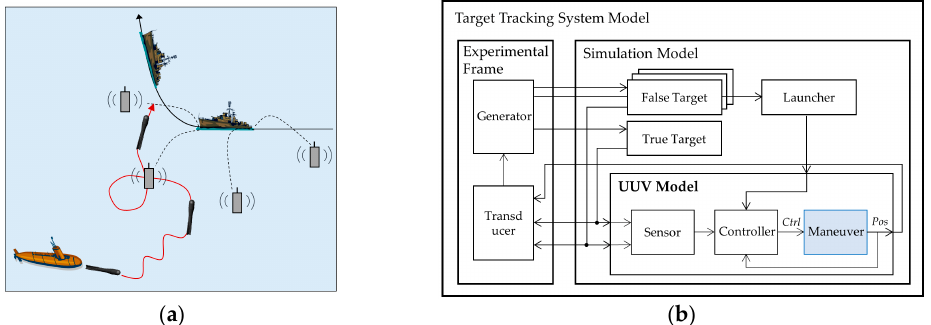
Figure 13. Case study for the dynamic system model: ( a ) UUV attacking scenario; ( b ) model structure of a UUV simulation.